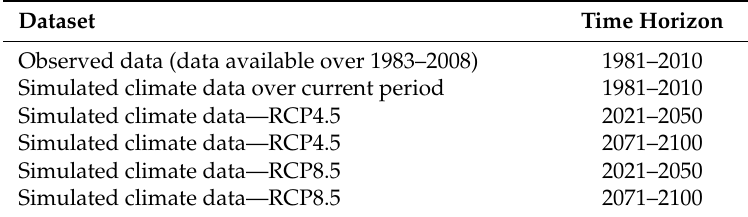
Table 1. 30-year datasets of atmospheric boundary